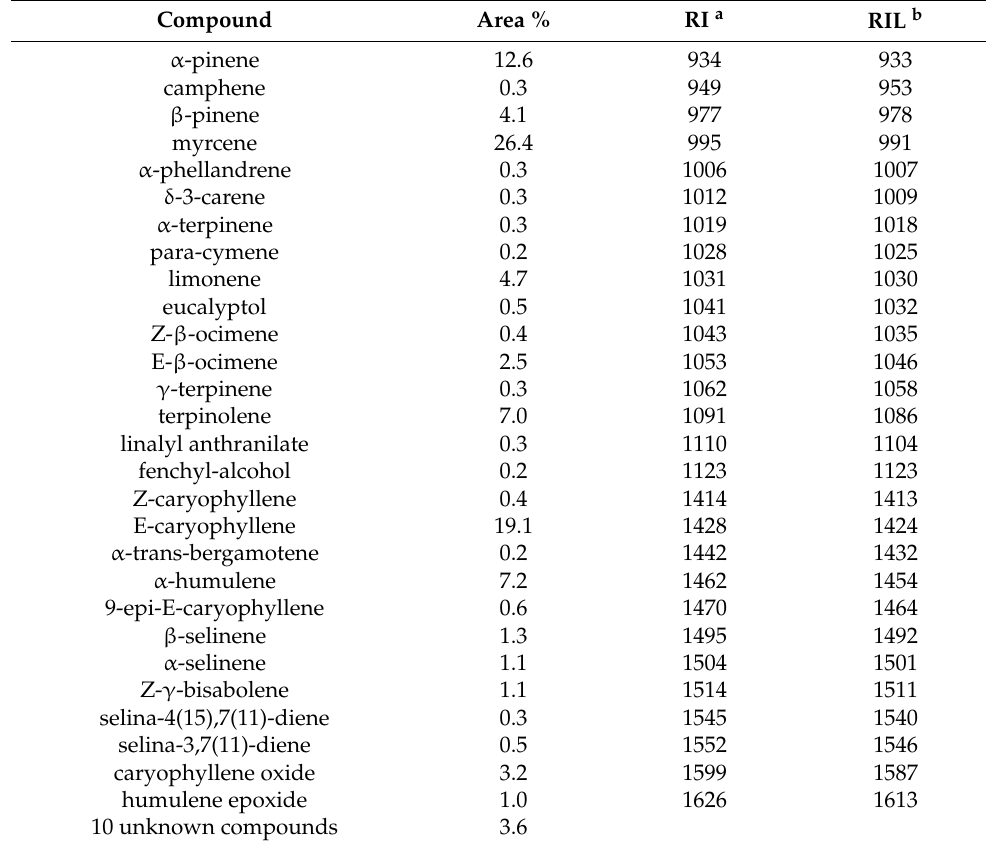
Table 3. GC–MS analysis of Carmagnola selezionata EO [25].